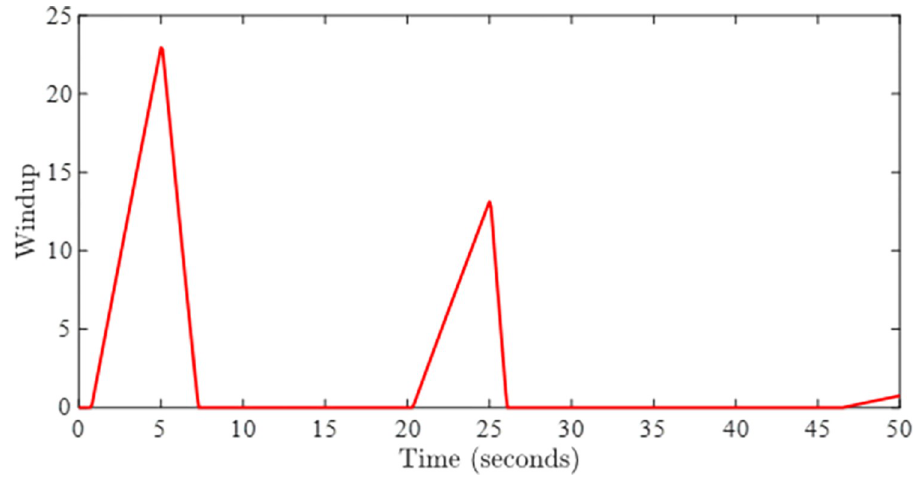
Fig 4. Windup effect without AWC.